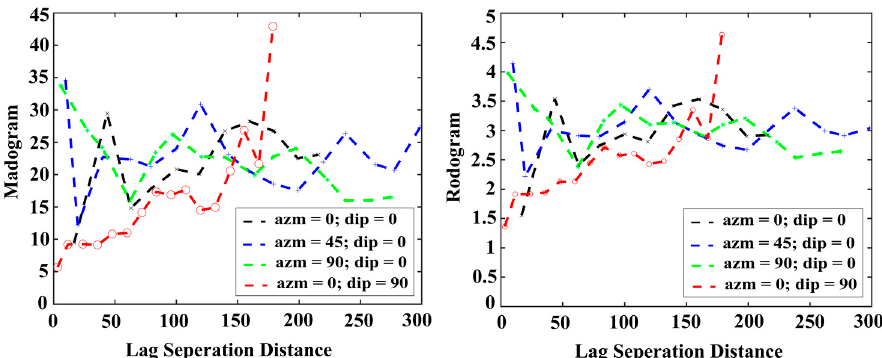
Figure 8. Modogram and rodogram for detection of anisotropy for RQD variable; red line shows the vertical anisotropy.